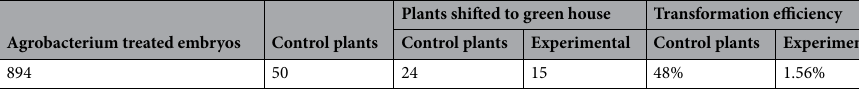
Table 3. Transformation efficiency.